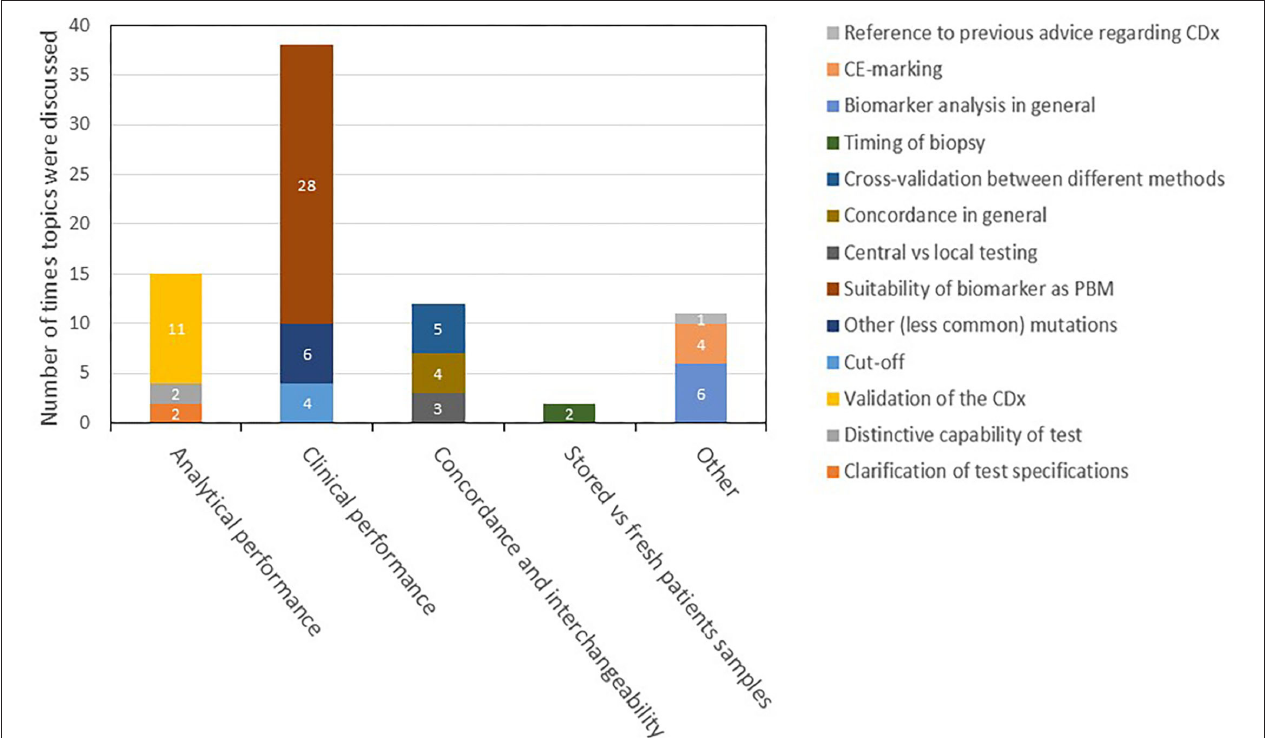
FIGURE 4 | Description and categorization of remarks on CDx found in day 80 ARs for medicines registered in 2017–2019. The four topics of CDx analytical performance, clinical performance, concordance and interchangeability, and testing of stored vs. fresh patient samples were further divided into subtopics. Remarks that did not fit to any of the four topics were categorized as “other.” AR, assessment report; CDx, companion diagnostic; EPAR, European public assessment report; PBM, predictive